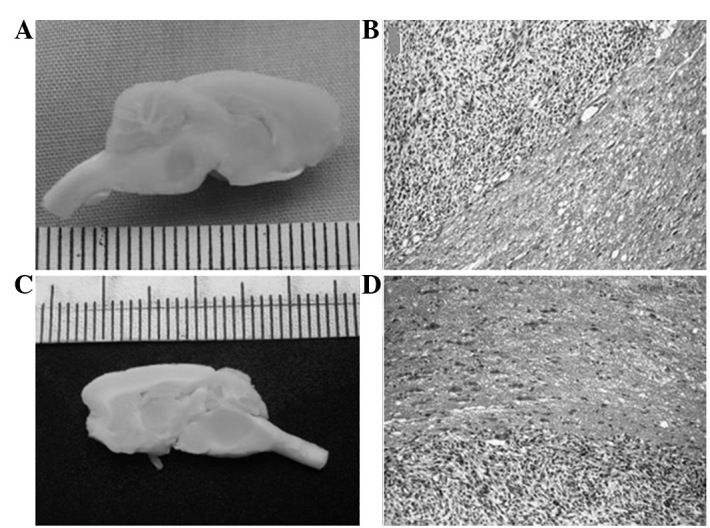
(A and C) Gross specimens of the juvenile and adult rats. The tumors were mass-like and there were significant differences with the surrounding normal tissue. (B and D) Invasive growth (HE; magnification, ×100). (A and B) represent group C and (C and D) represent group A. HE, hematoxylin and eosin.